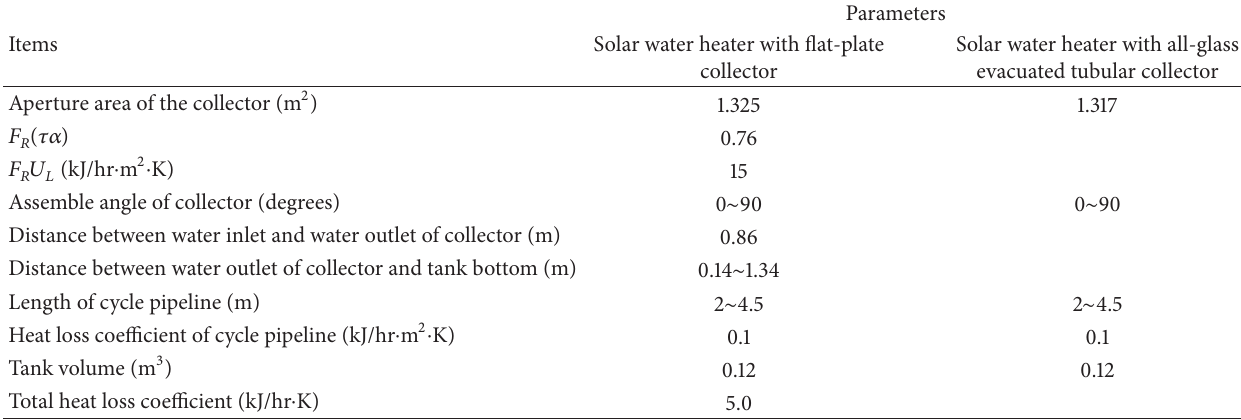
Table 2: Parameters of the solar water heaters.